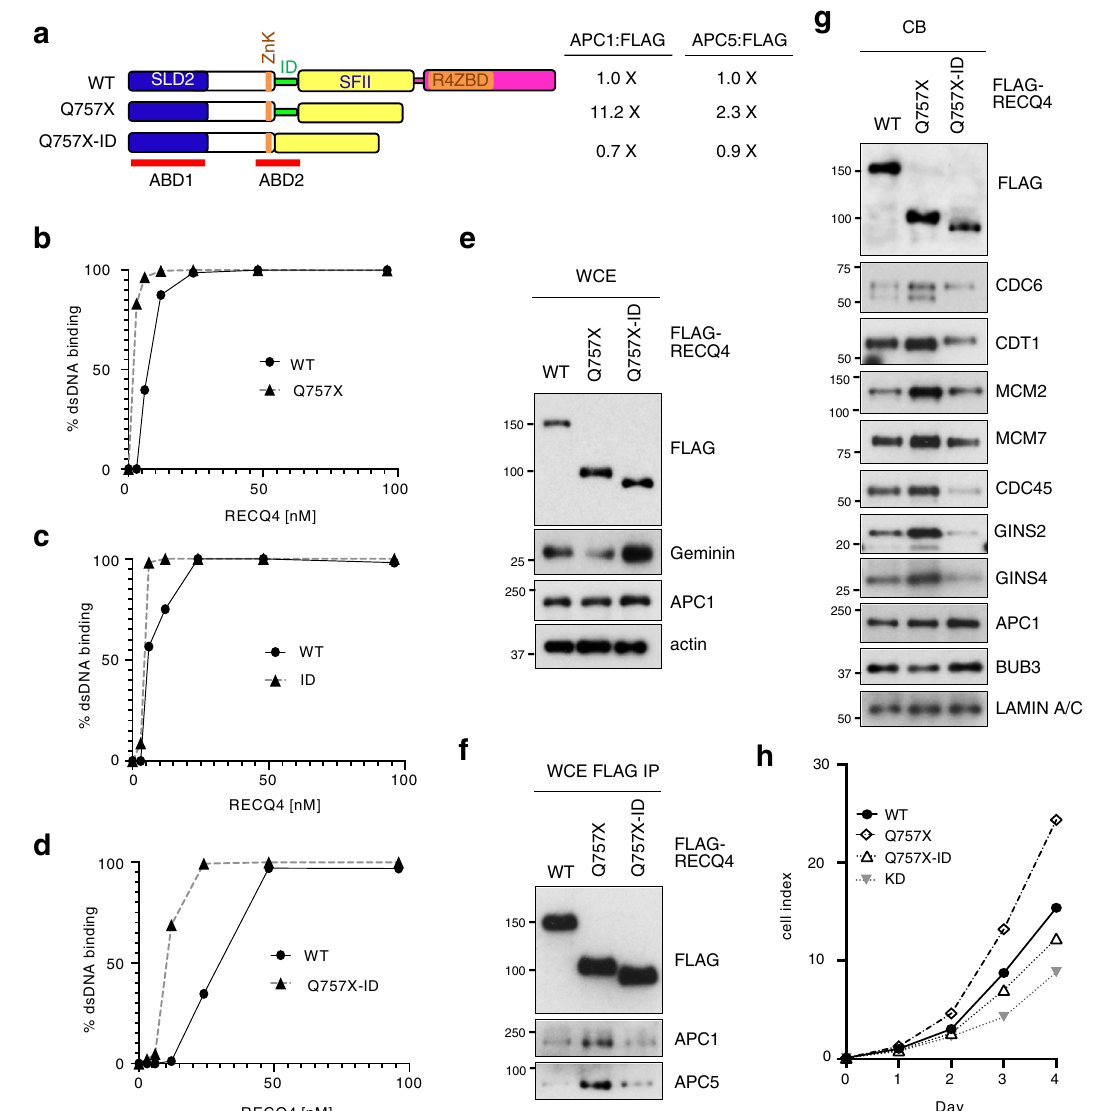
Fig. 5 | RECQ4 N-terminal interaction with APC/C promotes replisome assembly. a (left) A schematic diagram of RECQ4 wild type (WT), Q757X, and Q757X-internal-deletion (ID) double mutant. (right) Fold changes in the indicated co-puri fi ed proteins normalized to the bait FLAG-RECQ4 proteins relative com- paredtotheFLAG-RECQ4WTimmunoprecipitation(IP)basedonthewesternblot analysisshownin( f ). b – d Quanti fi cationofDNAbindingef fi ciencyofrecombinant His-tagged, FLAG-tagged RECQ4 Q757X ( b ), ID ( c ), or Q757X-ID ( d ) compared to WT RECQ4. e Representative western blot analysis of the indicated proteins in whole-cell extracts (WCE) prepared from RECQ4 knockdown (KD) HEK293 cells stably expressing RECQ4 WT, Q757X, or Q757X-ID. Actin was used as a loading